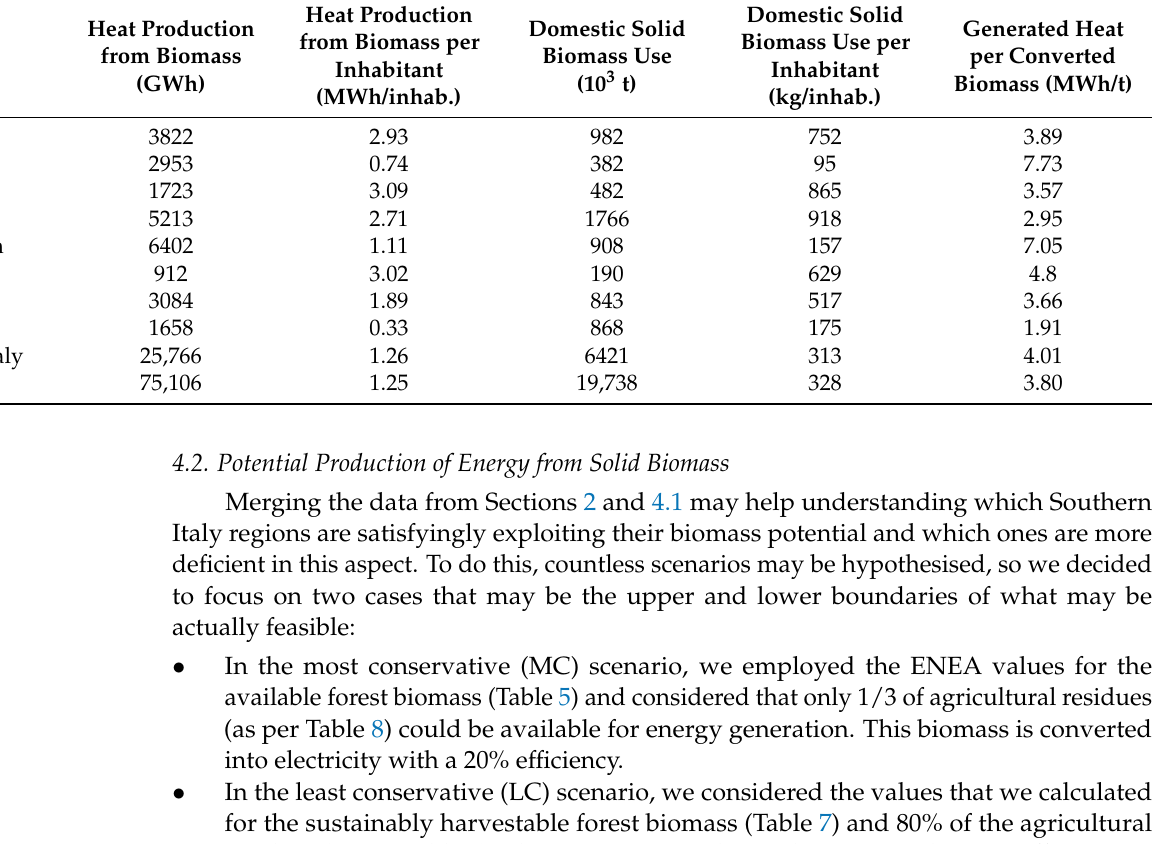
Table 11. Heat production from solid biomass and domestic use (partially adapted from [56] by GSE, www.gse.it). Heat Production Heat Production from Biomass per Region from Biomass Inhabitant (GWh) (MWh/inhab.)